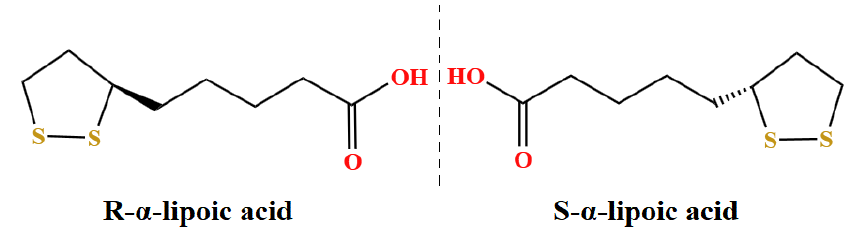
Figure 1. Chemical structure of S- form of α -lipoic acid and R- form of α -lipoic acid.